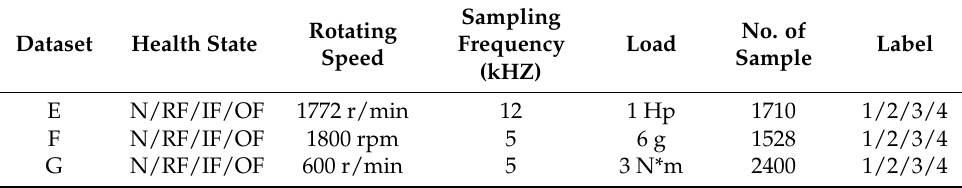
Table 5. Details of the bearing datasets of the diagnosis case